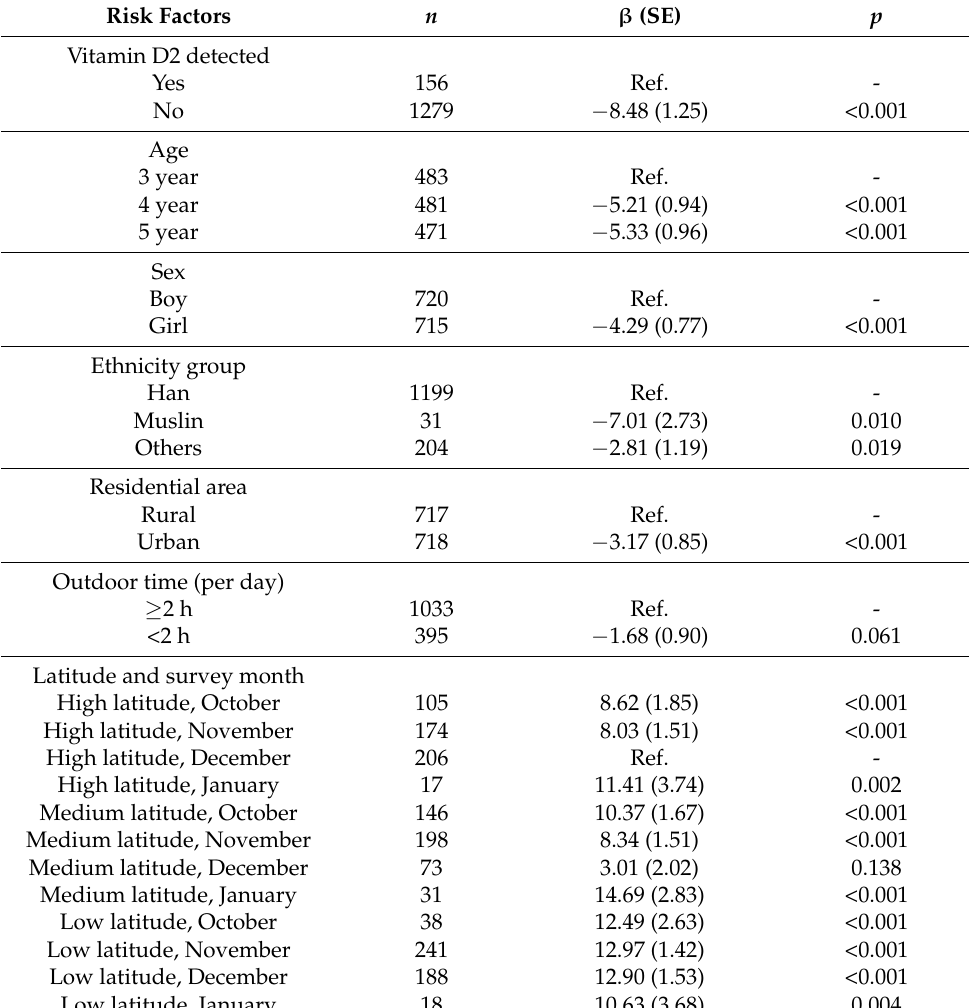
Table 2. Adjusted association of vitamin D2 detected and 25(OH)D concentration of children aged 3–5 years in China.